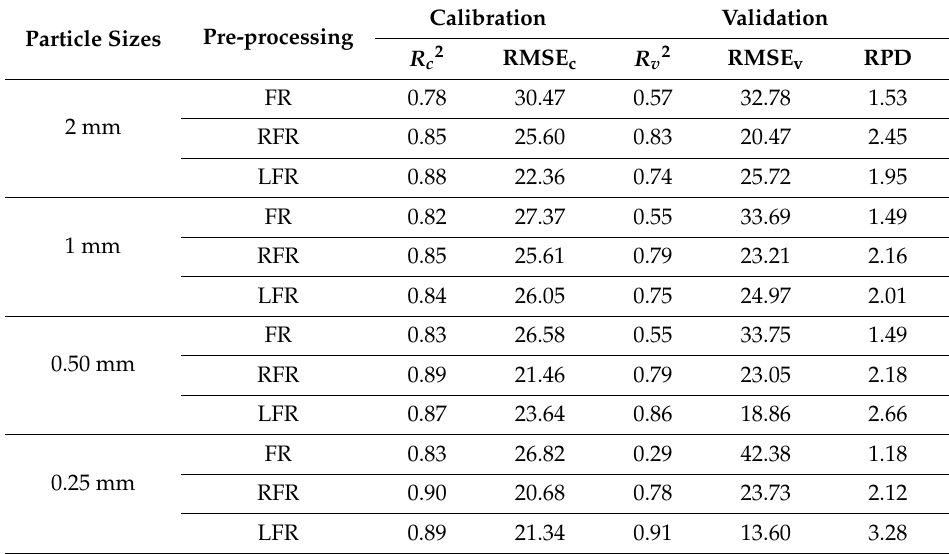
Table 4. Modeling results of stepwise multiple linear regression (SMLR) for SOM content.